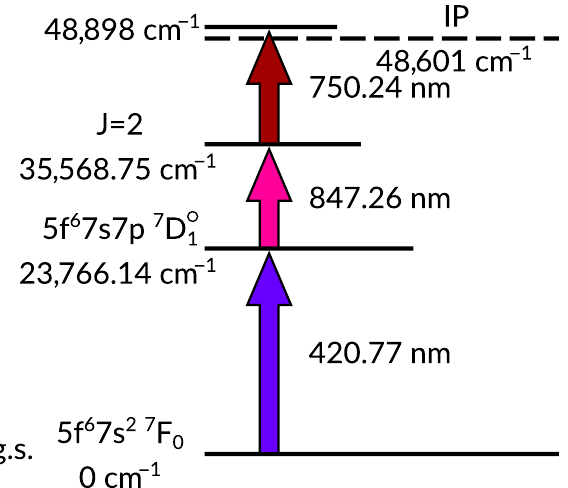
Figure 3. Resonance ionization scheme initially used in this work, developed for ultratrace analysis of environmental samples [33]. The three step blue-IR-IR scheme drives the electrons to an auto-ionizing state located at 48,898 cm − 1